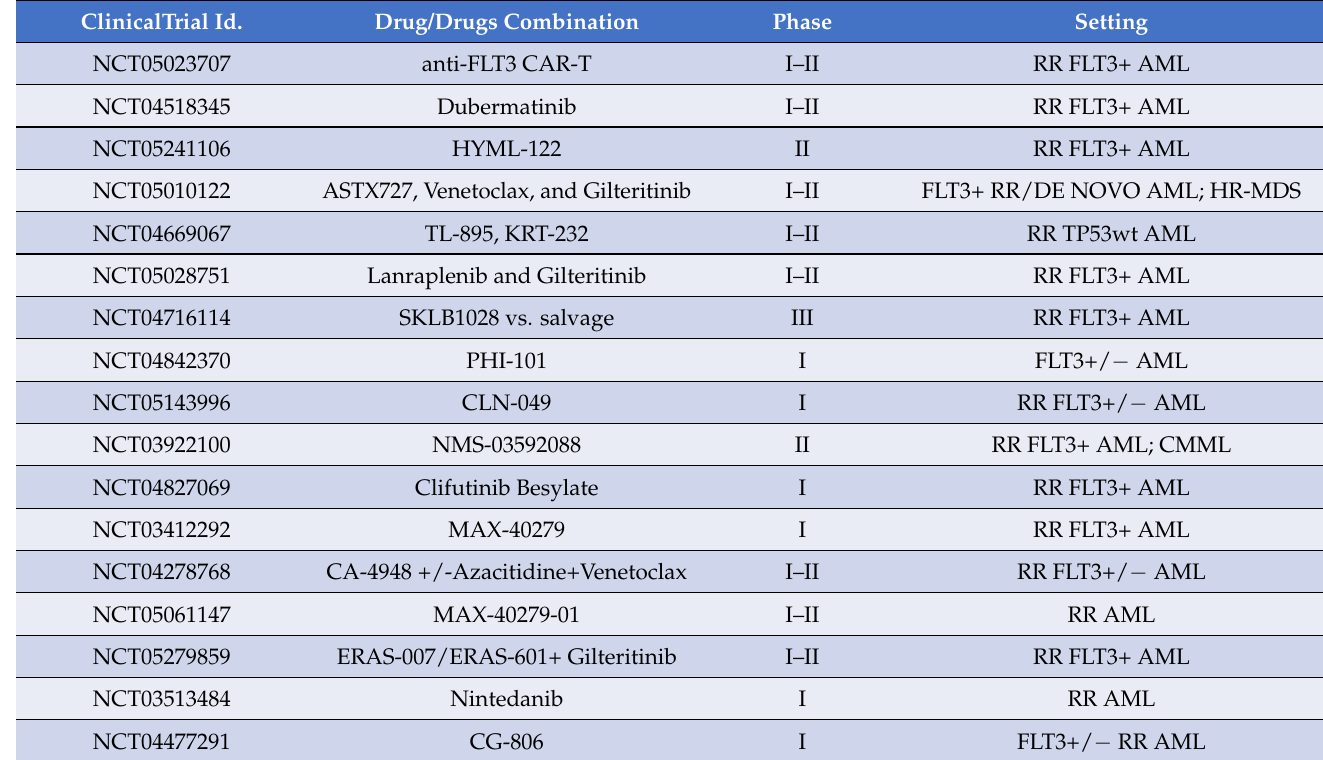
Table 6. List of ongoing clinical trials including combination of new multitarget agents and FLT3i or hypomethylating